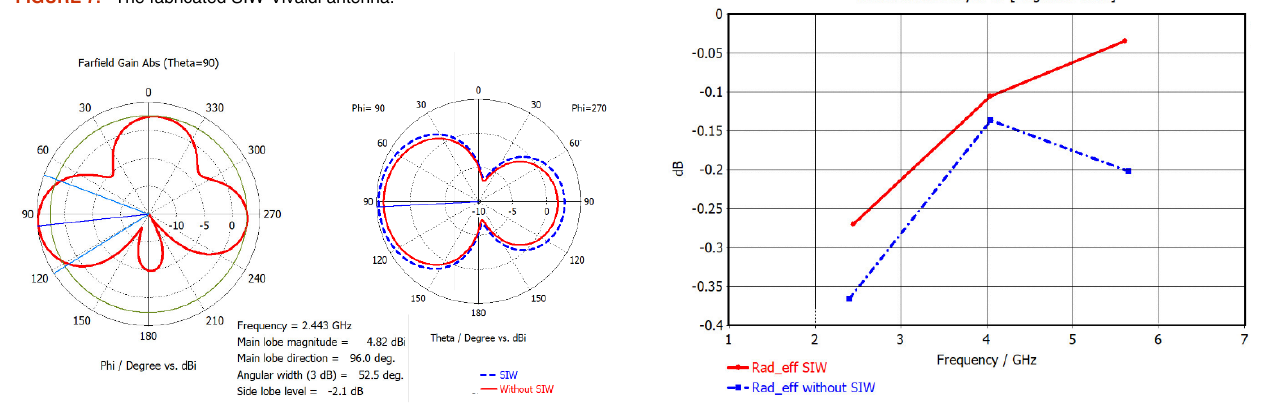
FIGURE 7. The fabricated SIW-Vivaldi antenna.